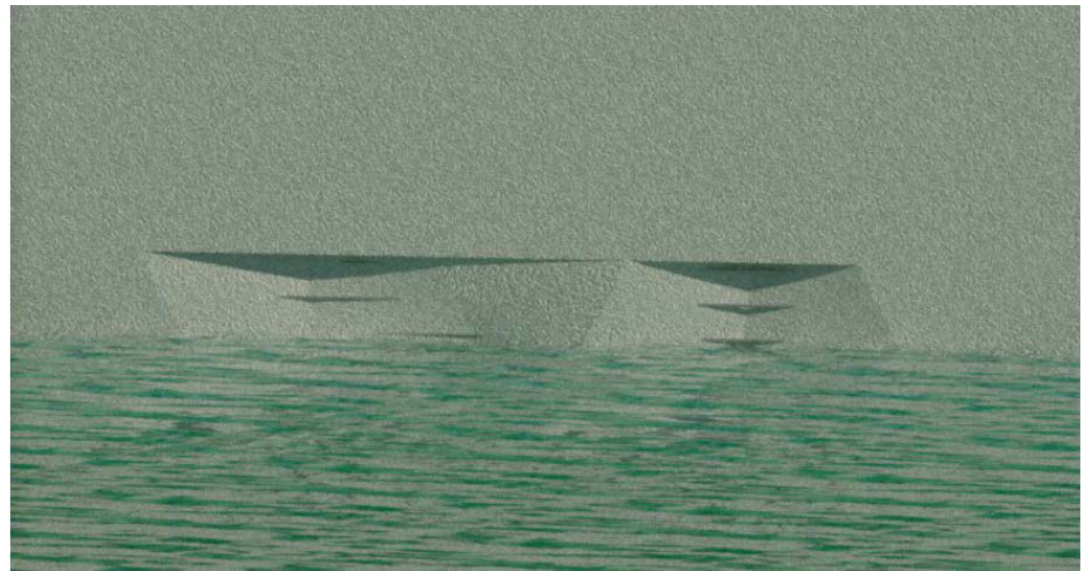
Figure 9. Presence of cracks and corrosion of the armor of the reinforcement of the caisson that makes up the spur breakwater.